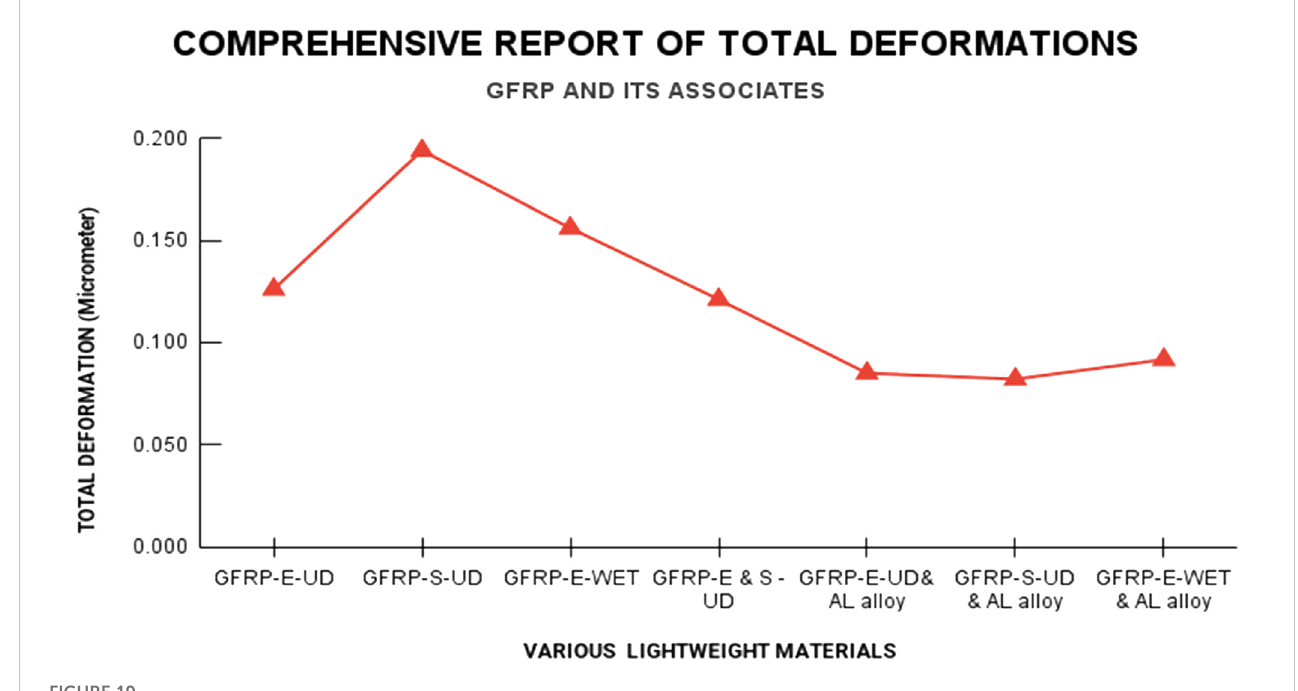
Total deformation on full fuselage of RUAV with GFRP and its associate materials.